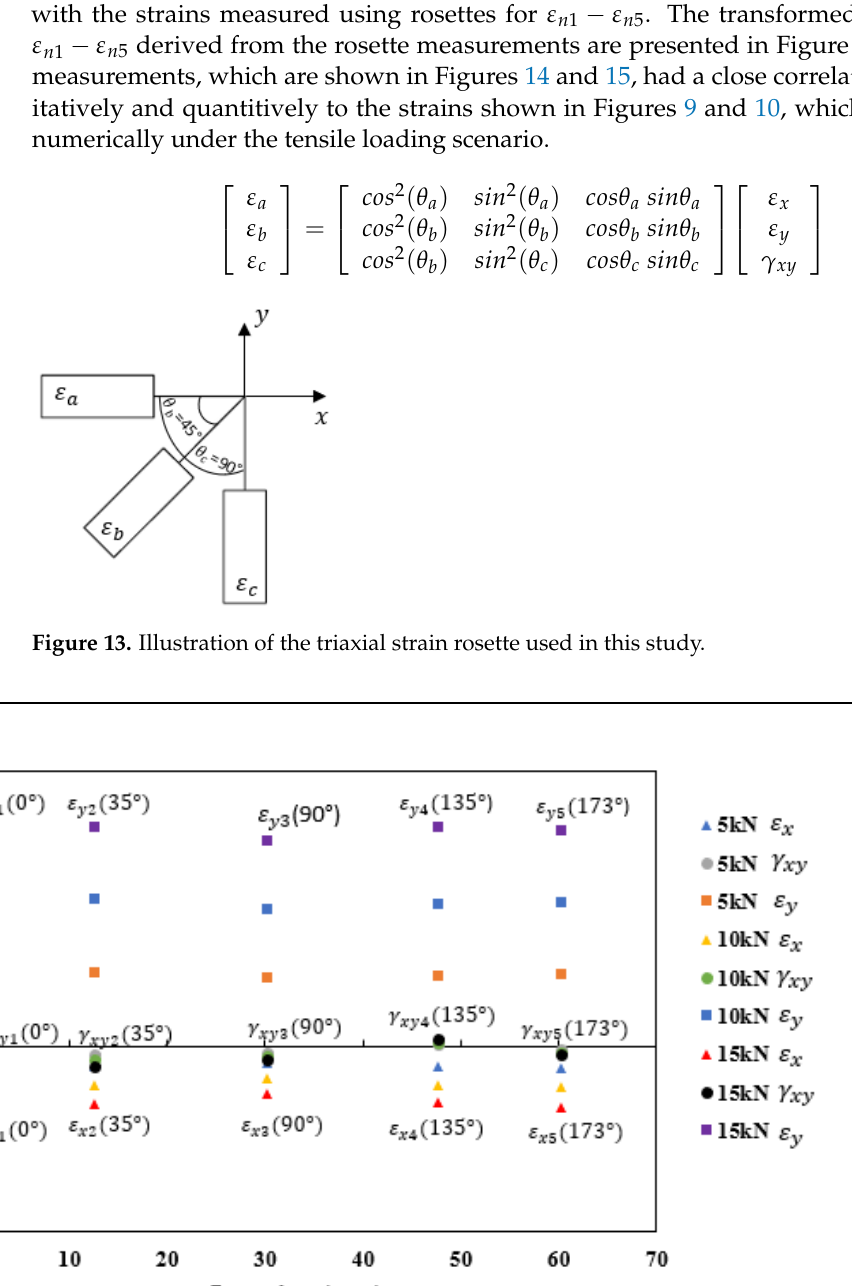
− ε − ε x 5 , ε y 1 y 5 , and γ xy 1 x 1